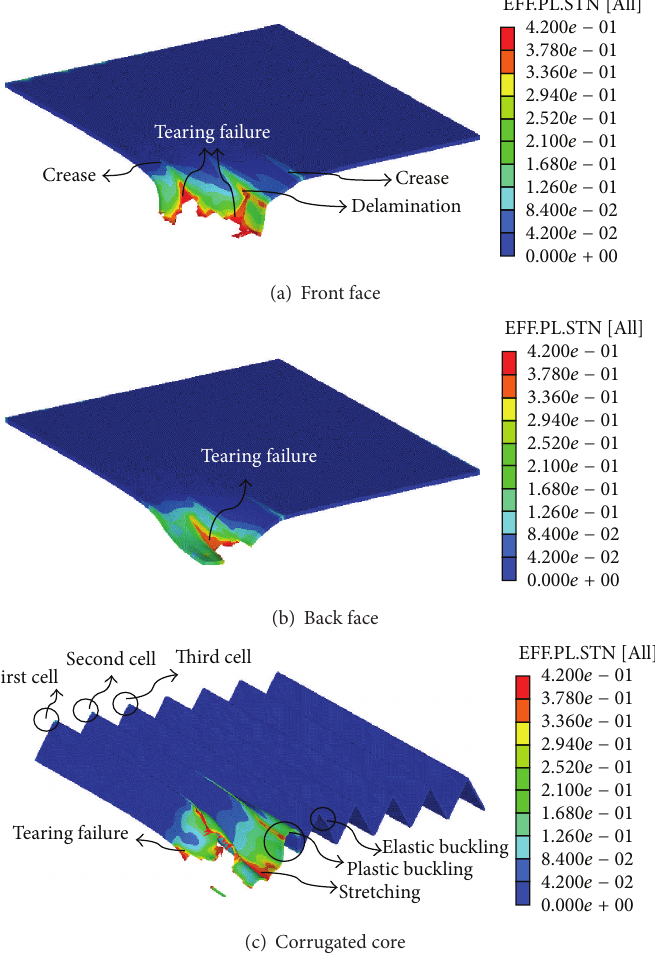
Figure 8: Deformation and failure patterns of a sandwich panel (case number S20-1). (For interpretation of the references to colour in this figure legend, the reader is referred to the web version of this